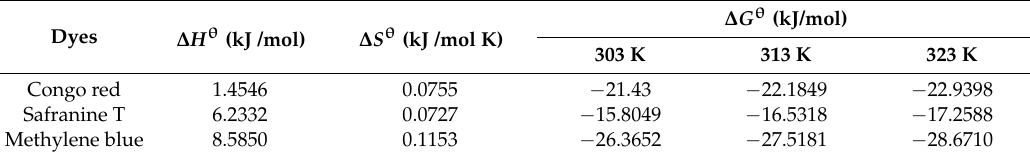
Table 1. Thermodynamic parameters for dye adsorption onto Bio-SeNPs.